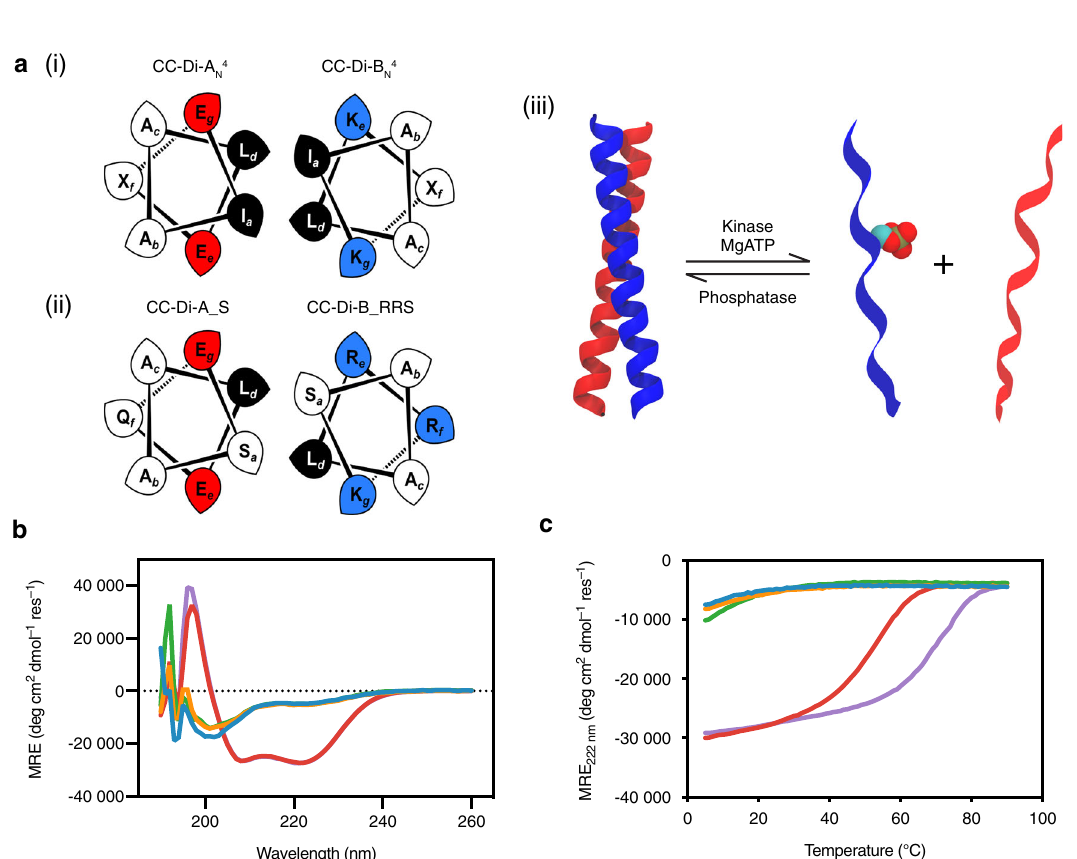
Fig. 1 Design and solution-phase characterization of phosphorylation-switchable coiled-coil heterodimers. a Helical wheels for the (i) parent and (ii) CC-Di-A_S:CC-Di-B_RRS coiled-coil (CC) designs, and (iii) illustration of the switching concept. In its unphosphorylated state, CC-Di-B_RRS (blue) forms a heterodimeric CC with CC-Di-A_S or CC-Di-A N 4 (red). Phosphorylation of CC-Di-B_RRS by a protein kinase (e.g. PKA) prevents this dimerization due to the bulk and charge of the phosphoryl moiety. Dephosphorylation by a protein phosphatase (e.g. lambda protein phosphatase) re-enables dimerization. b CD spectra of individual peptides and their combinations acquired at 25 °C in phosphate-buffered saline (PBS) at pH 7.4: blue, CC-Di-A_S; orange, CC- Di-A N 4 ; green, CC-Di-B_RRS; red, CC-Di-A_S:CC-Di-B_RRS; and purple, CC-Di-A N 4 :CC-Di-B_RRS. c Thermal unfolding curves of individual peptides and their combinations in PBS at pH 7.4. The concentration of each peptide was 50 μ M in all CD (Fig. 1a). The resulting peptide is referred to as CC-Di-B_RRS hereafter (Table 1).